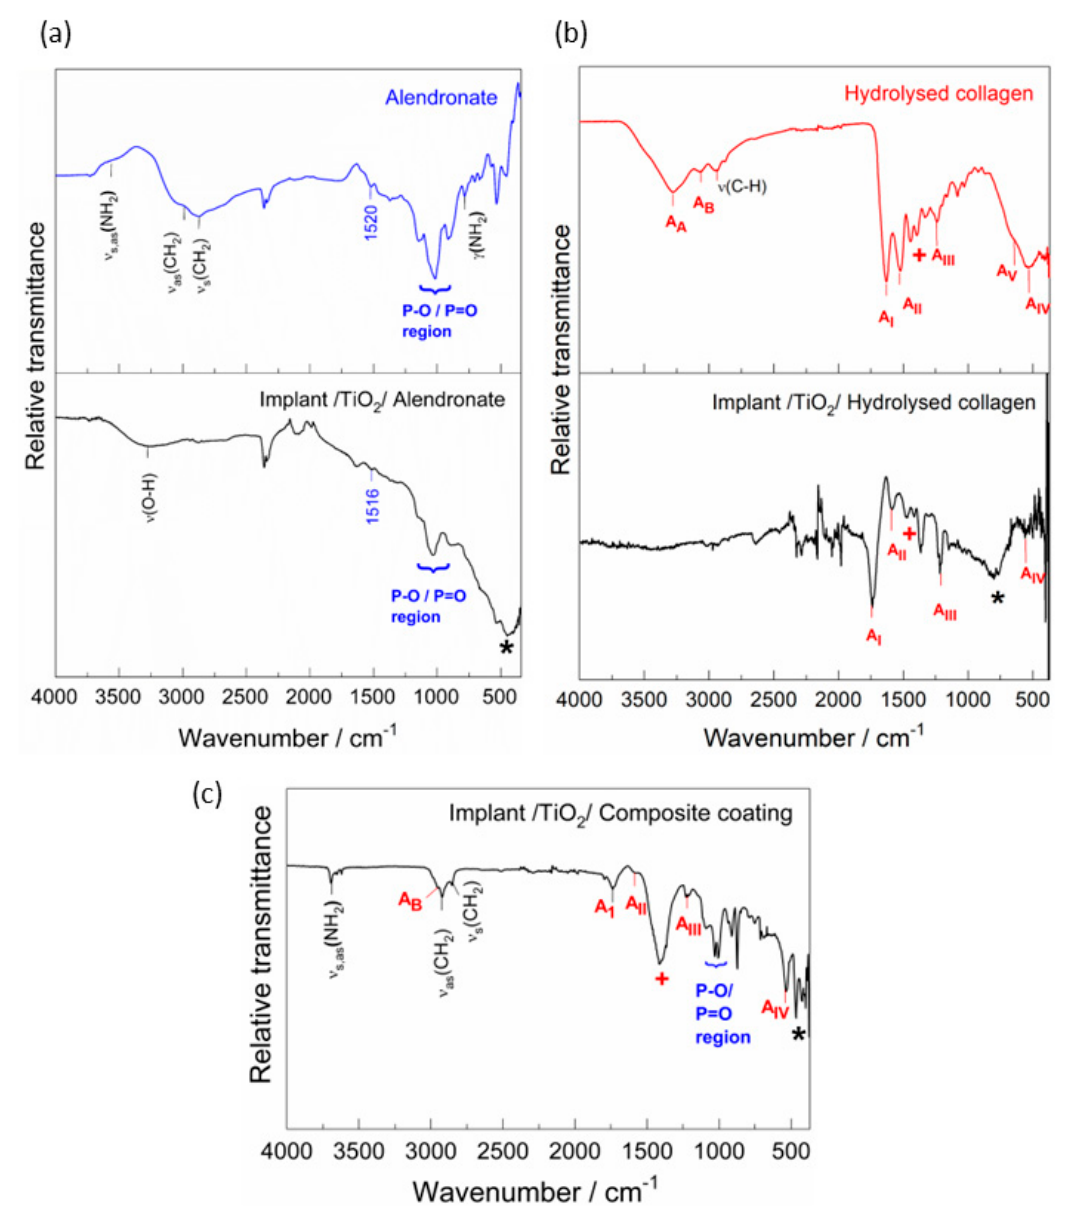
Figure 2. The ATR-FTIR spectra of ( a ) alendronate sodium and the implant functionalised with alendronate, ( b ) hydrolysed collagen and the implant functionalised with hydrolysed collagen, and ( c ) the implant functionalised with composite coating of alendronate and hydrolysed collagen. *: TiO 2 vibration; +: CH 2 wagging vibrations of glycine and proline.